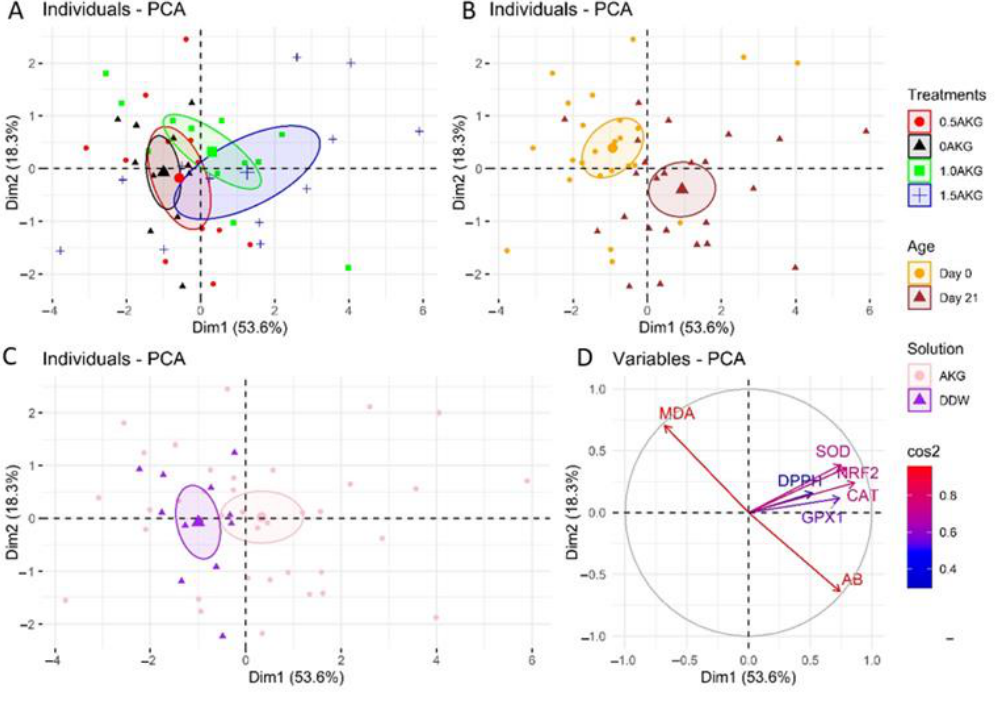
Figure 4. Principal component analysis (PCA) plot of individuals and variables. An individual refers to a sampled bird per treatment while a variable is a biological parameter analyzed. The individuals have been colored according to the treatments ( A ), age ( B ), and solution injected ( C ). The variables have been colored based on their squared cosine ( D ). The PCA was executed in R using the package “FactoMineR”. Abbreviations: NRF2, nuclear factor erythroid 2-related factor; SOD, superoxide dismutase; CAT, catalase; GPX1, glutathione peroxidase 1; AB, antioxidant balance; MDA, malondialdehyde; DPPH, 2,2-diphenyl-1-picrylhydrazyl free radical scavenging activity; Dim1, dimension 1; Dim2, dimension